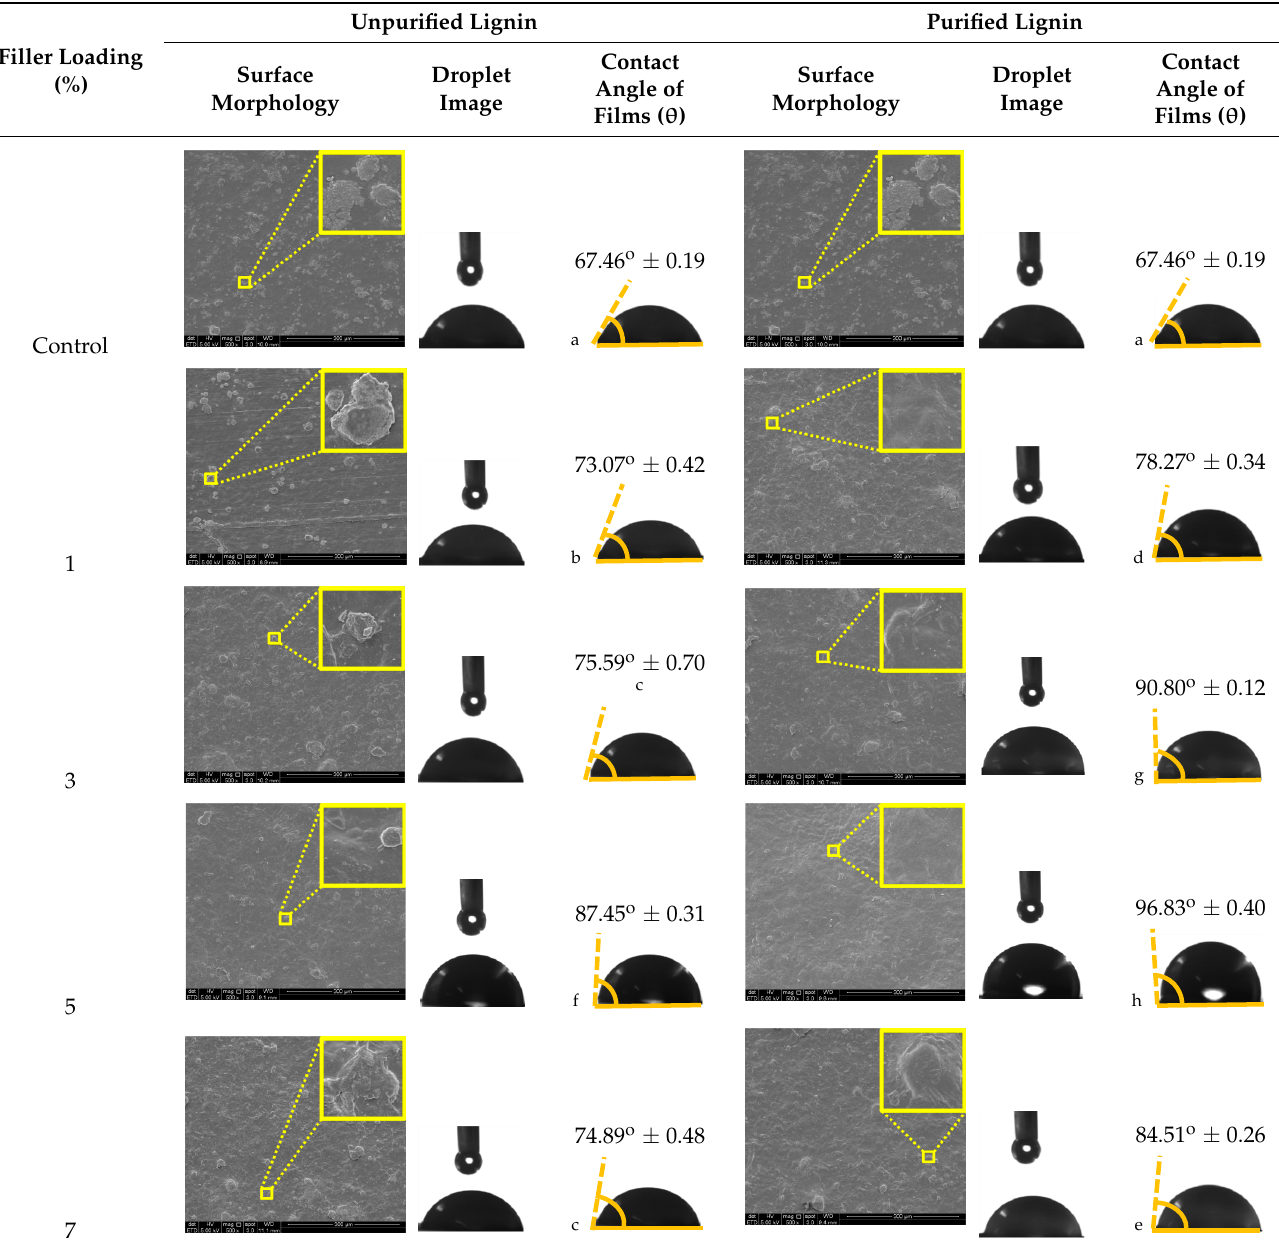
Table 3. The FESEM images of surface morphology and contact angle properties of macroalgae-based biopolymer film reinforced unpurified and purified LNPs.